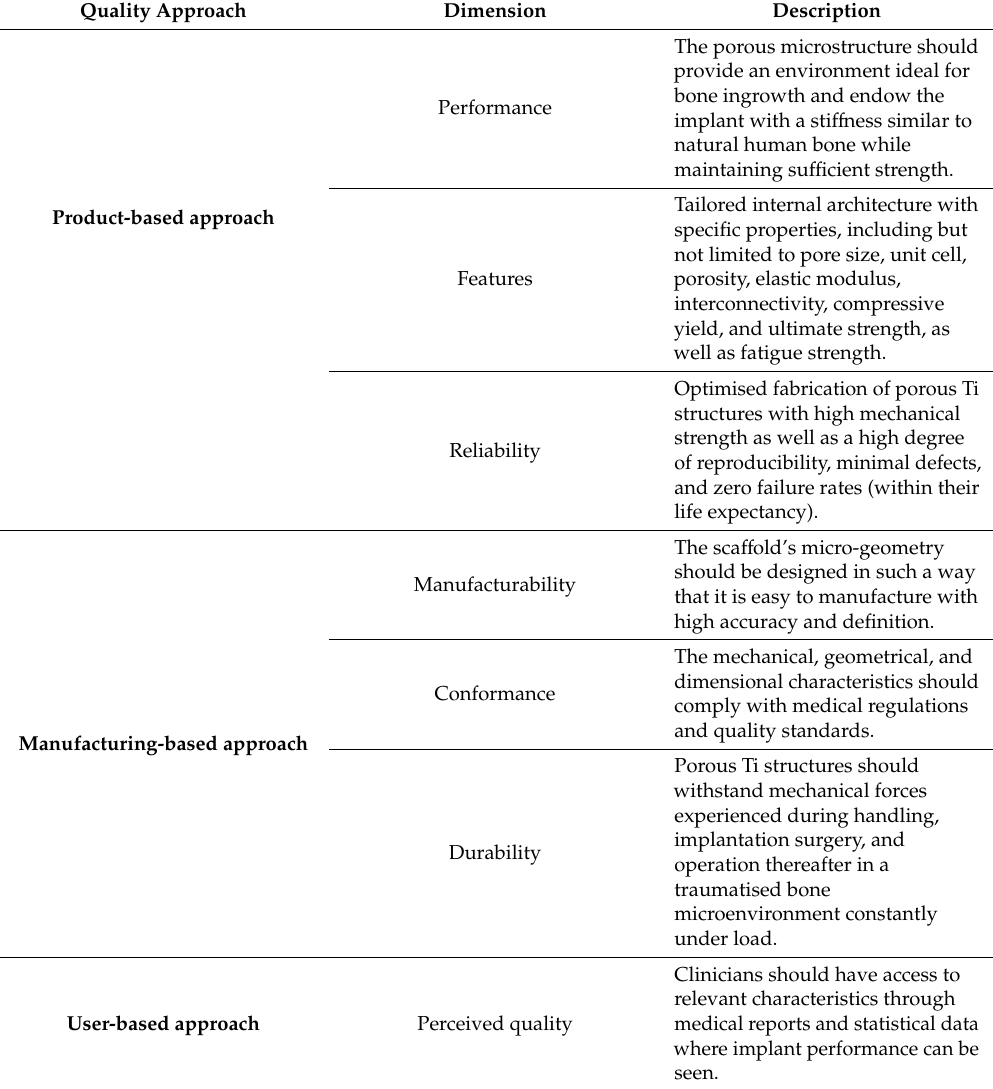
Table 4. The ideal quality dimensions of porous internal architecture of Ti bone